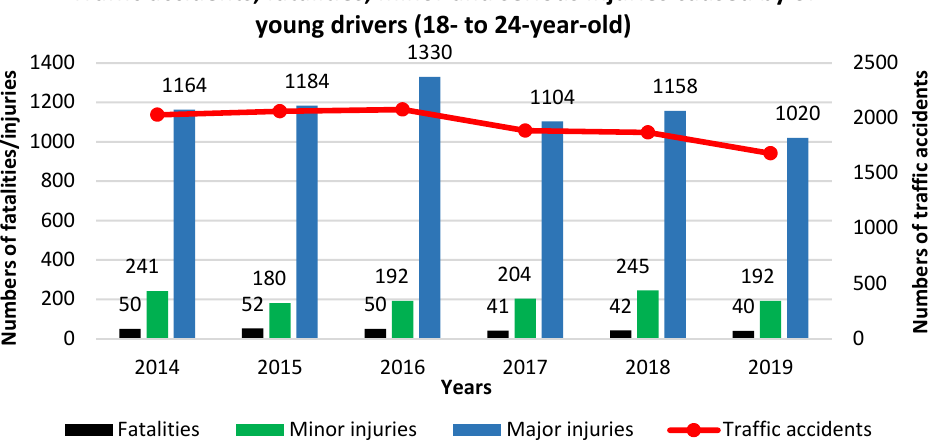
Figure 1. Annual number of traffic accidents caused by young drivers). Processed with permission from ref. [29]. 2020 Presidium of the Police Force, Ministry of Interior of the Slovak republic. Drivers with a lack of driving experience cause 27% to 36% of traffic accidents. Table 1 shows the complete data for only the group of drivers with less than five years of experience. The extreme value is the number of fatalities in 2016, where inexperienced drivers caused the deaths of up to 63 people (36% of the total number). The number of traffic accidents decreases each year, but the number of fatalities is stagnating. Table 1. Traffic accidents of new drivers (with less than 5 years of experience). Reprinted